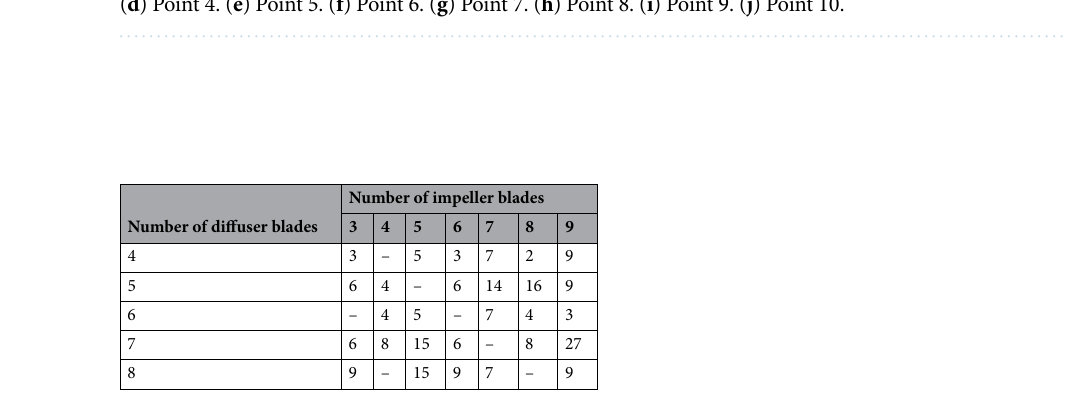
Table 7. Expected centrifugal pump blade-passing